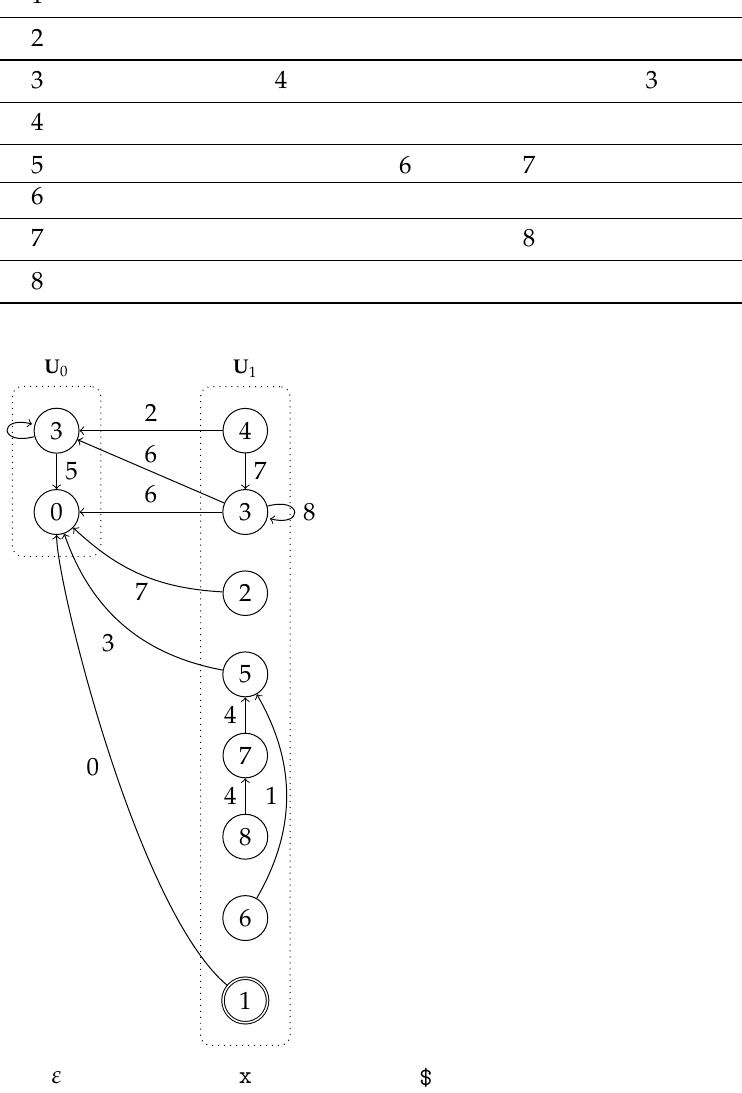
Figure 21. The GSS constructed by our architecture using the specification Ξ in (5).